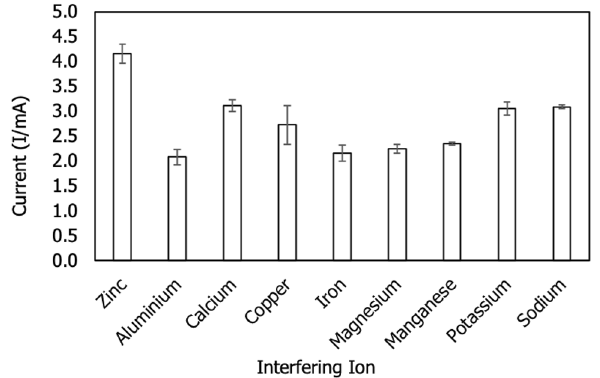
Figure 11. Bar charts of interfering ions for selectivity test of zinc sensor.